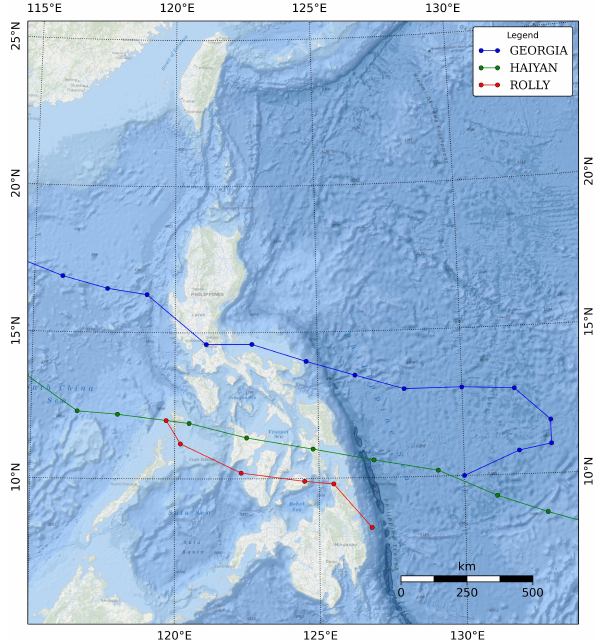
Figure 4. Tracks of Typhoon Georgia (1964), Tropical Depression Rolly (2008), and Typhoon Haiyan